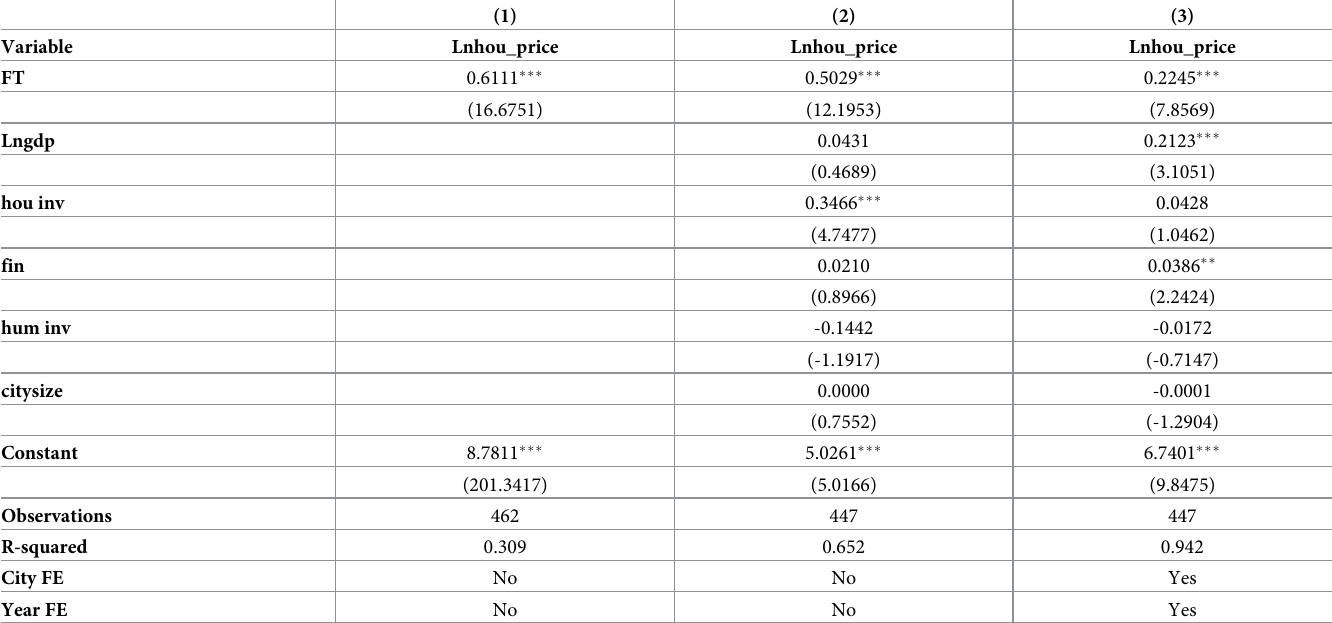
Table 5. Sample excluding mega cities.